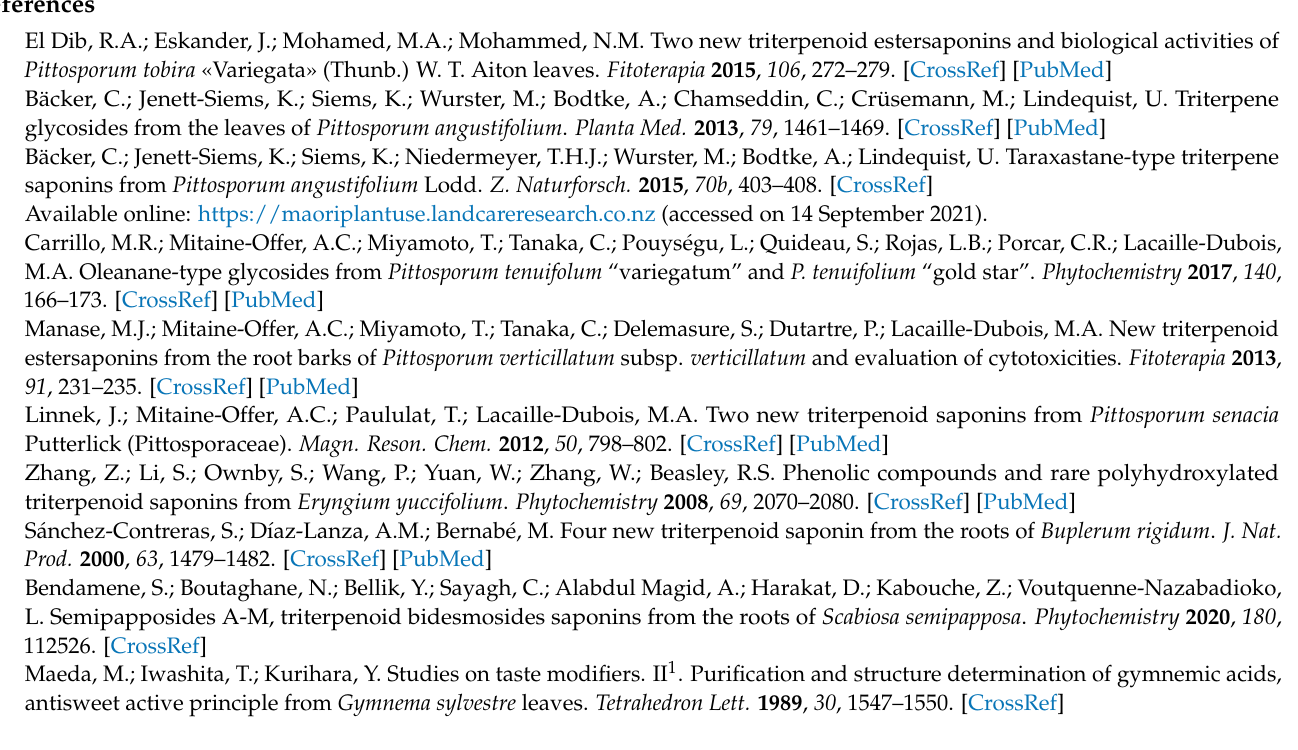
pound 1 ; Figure S2. HMBC spectra of compound 1 ; Figure S3. COSY spectrum of compound 1 ; Figure S4. TOCSY spectrum of compound 1 ; Figure S5. ROESY spectrum of compound 1 ; Figure S6. HSQC spectrum of compound 2 ; Figure S7. HMBC spectra of compound 2 ; Figure S8. COSY spectrum of compound 2 ; Figure S9. TOCSY spectrum of compound 2 ; Figure S10. ROESY spectrum of compound 2 ; Figure S11. Activation of hTAS1R2-hTAS1R3 by sucralose; Figure S12. Inhibitory effect of GS on the response of sucralose by